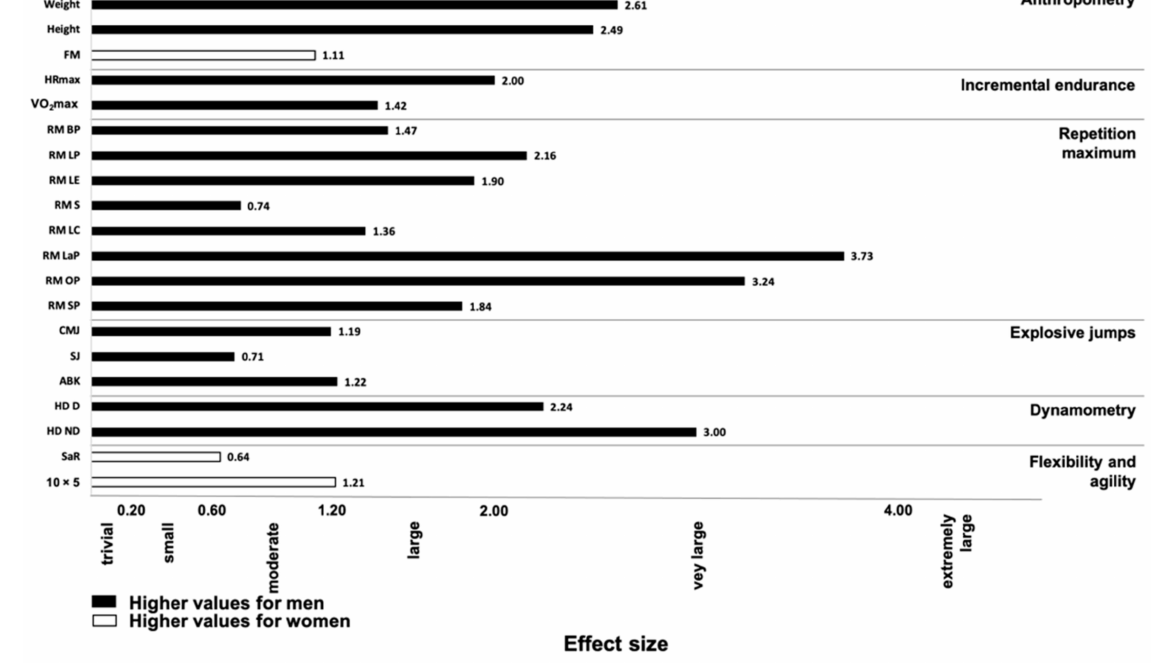
Figure 1. Effect sizes for the gender differences in physical parameters of professional padel players. FM: fat mass; RM: one repetition maximum; BP: bench press; LP: leg press; LE: leg extension; LC: leg curl; LaP: lat pulldowns; OP: overhead press; SP: shoulder press; CMJ: countermovement jump; ABK: Abalakov; HD: hand dynamometer; D: dominant; ND: non-dominant; SaR: sit and